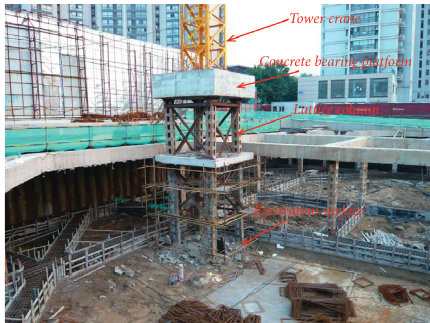
Figure 1: The combined tower crane foundation.